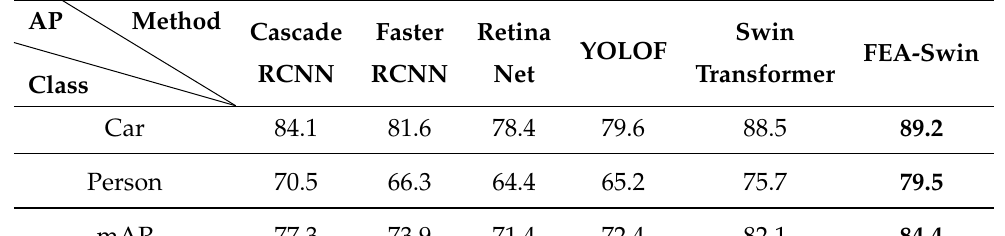
Table 3. Comparison results on our self-collected dataset. The bolded numbers are the best indicators for each category.